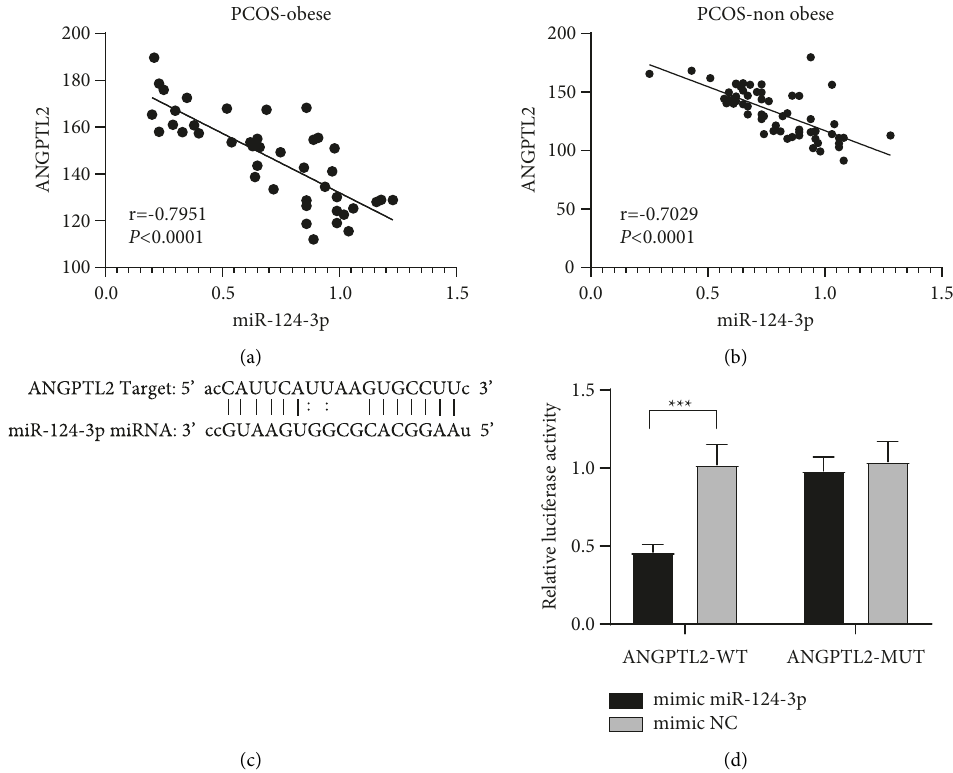
Figure 3: miR-124-3p targeted ANGPTL2. (a, b) The relationship between miR-124-3p and ANGPTL2 mRNA level in obese and nonobese PCOS patients. (c) The binding sites between miR-124-3p and ANGPTL2 predicted using the StarBase database. (d) The binding rela- tionship of miR-124-3p and ANGPTL2 was detected with a dual-luciferase assay. Pearson correlation analysis was used in panels A/B, and the nonpaired t -test was used in panel D. ∗∗∗ P < 0 .